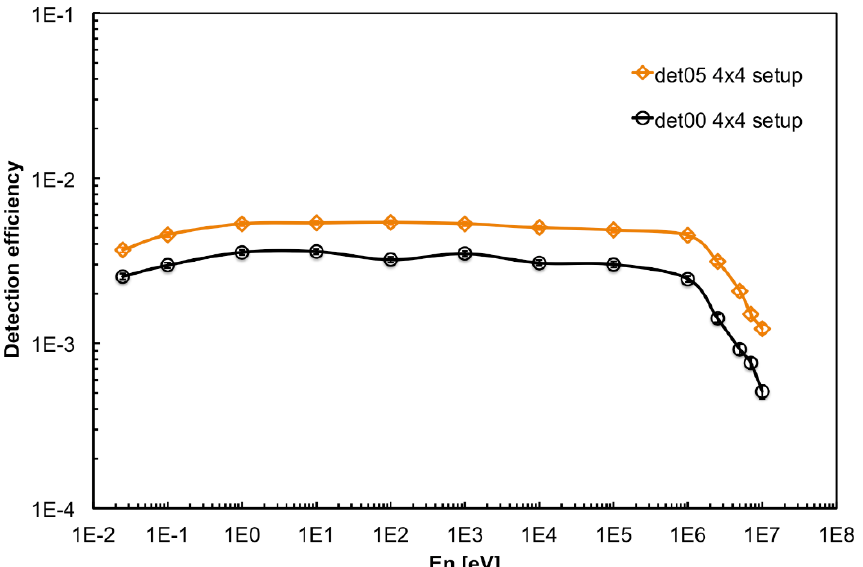
Figure 21. Comparison between a corner (det00) and a central (det05) detector simulated efficiency. The overall shapes are similar, the difference being essentially a scale factor enhancement for the central detector due to a geometrical effect of the neighboring moderators.